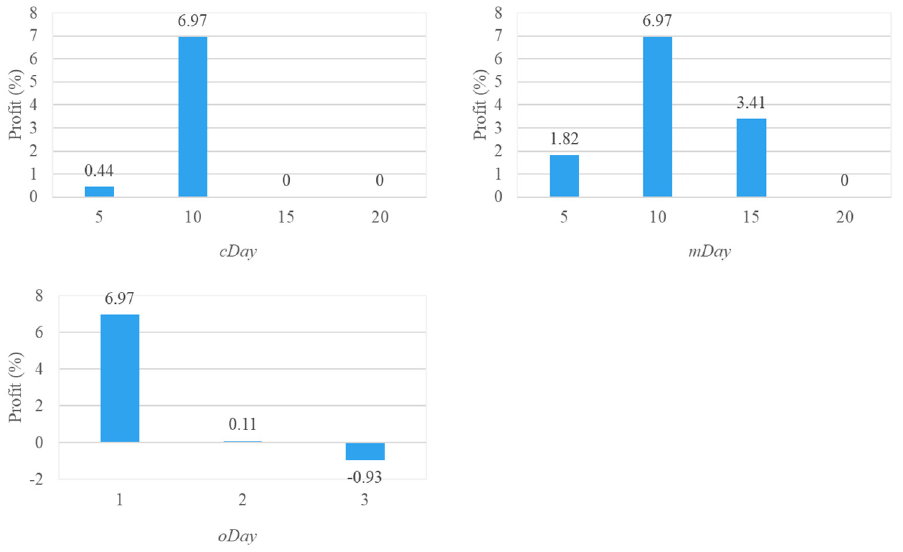
Figure 10. Profit of different parameter settings on one-year dataset (2012).